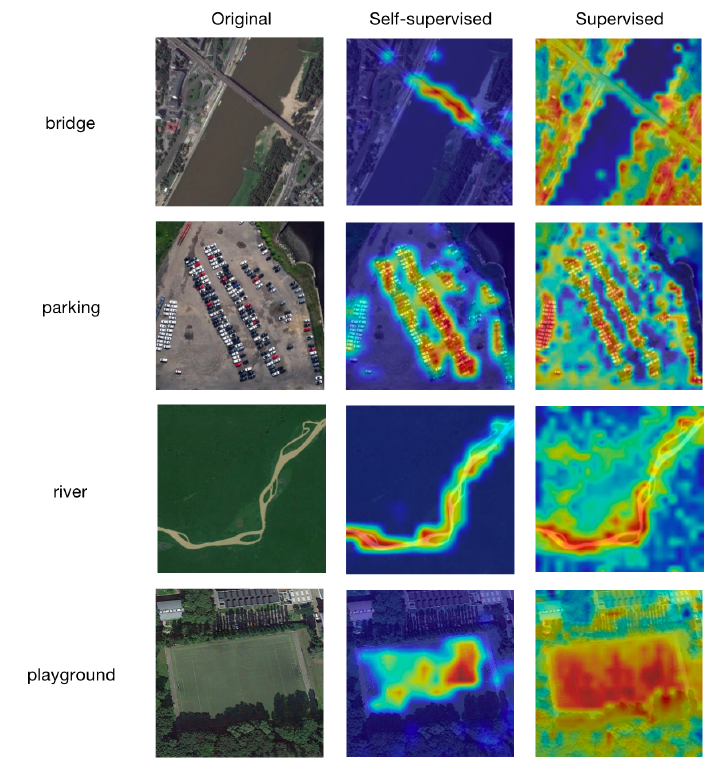
Figure 5. Self-supervised and fully supervised learning visualizations on AID